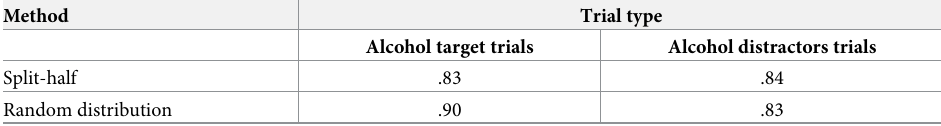
Table 3. Internal consistency reported for the split-half and random distribution method per trial type for the Visual Search